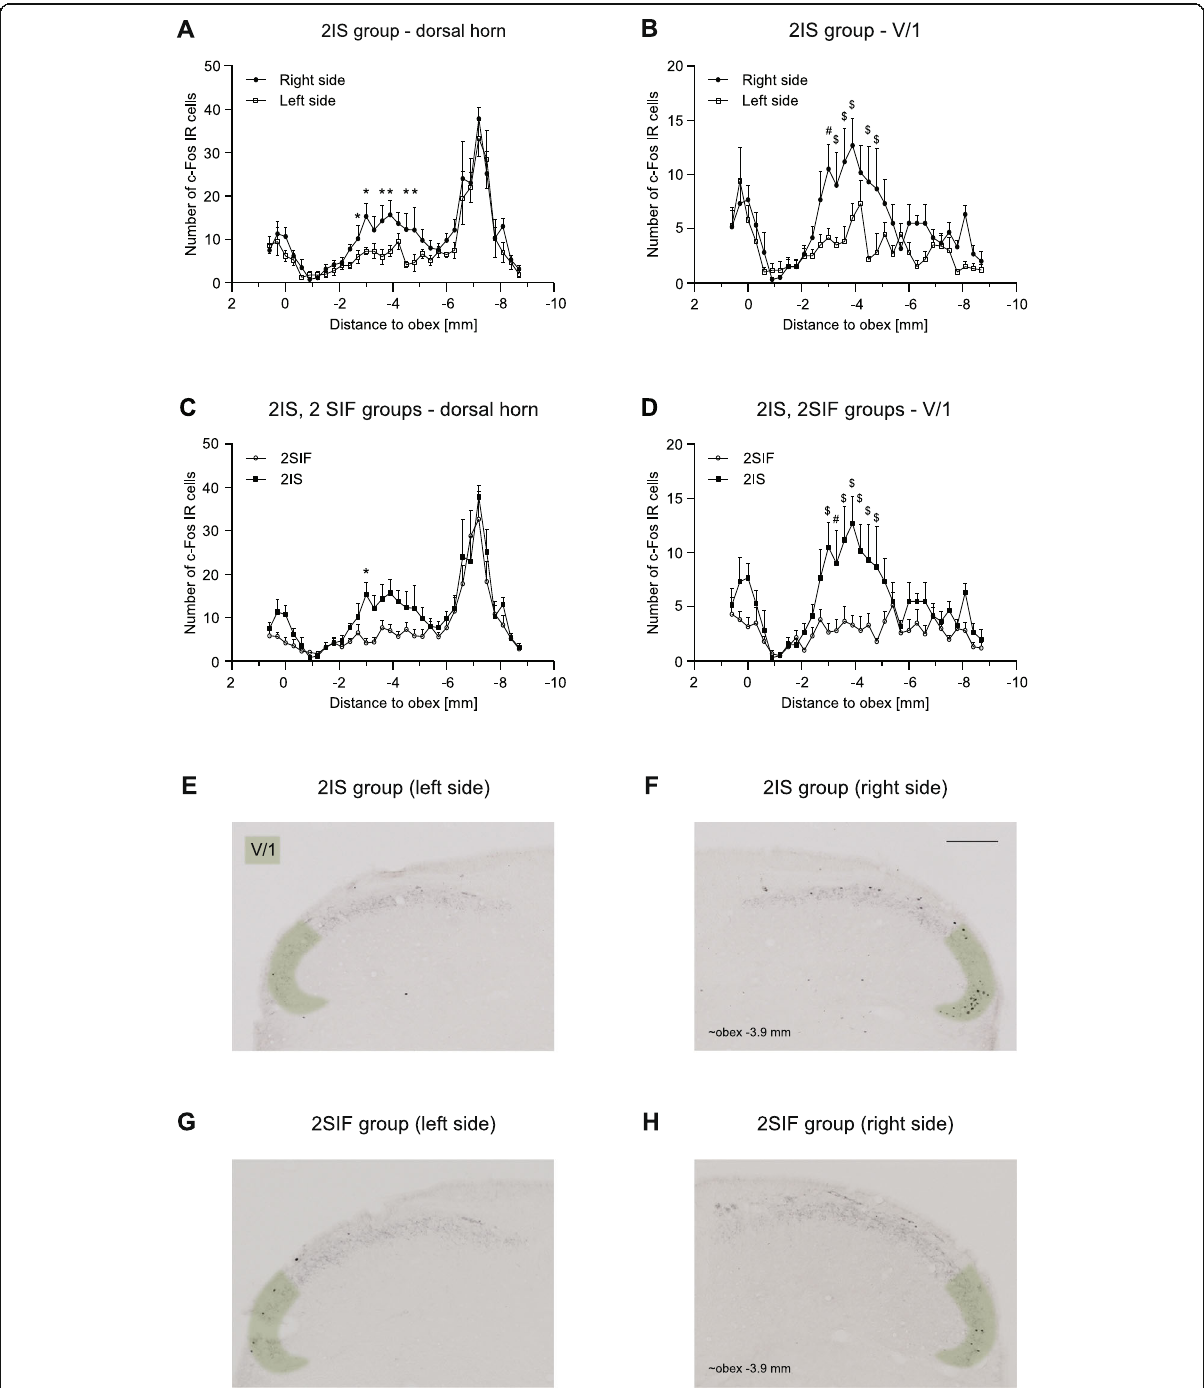
Fig. 5 Diagrams showing c-Fos immunoreactive cells across different levels of TNC (mean + SEM) in the whole dorsal horn a , c and the V/1 area b , d 2.5 h after IS a , b , c , d or SIF c , d . Representative photomicrographs showing c-Fos IR cells in the dorsal horns of 2IS e , f , 2SIF groups g , h . Green highlighting shows the V/1 area in the dorsal horn. Scale bar: 200 μ m. We found significant difference between right and left side of the dorsal horn laminae I-II a , and the ventral part of the dorsal horn b . IS caused significant difference in the number of c-Fos positive cells in the V/ 1 area d . Peak at obex follows the activation pattern of FRE, substantial peak at obex ( − 6) - ( − 8) mm is consistent with the increased number of cells found in NAT group (* p < 0.05, # p < 0.01, $ p <